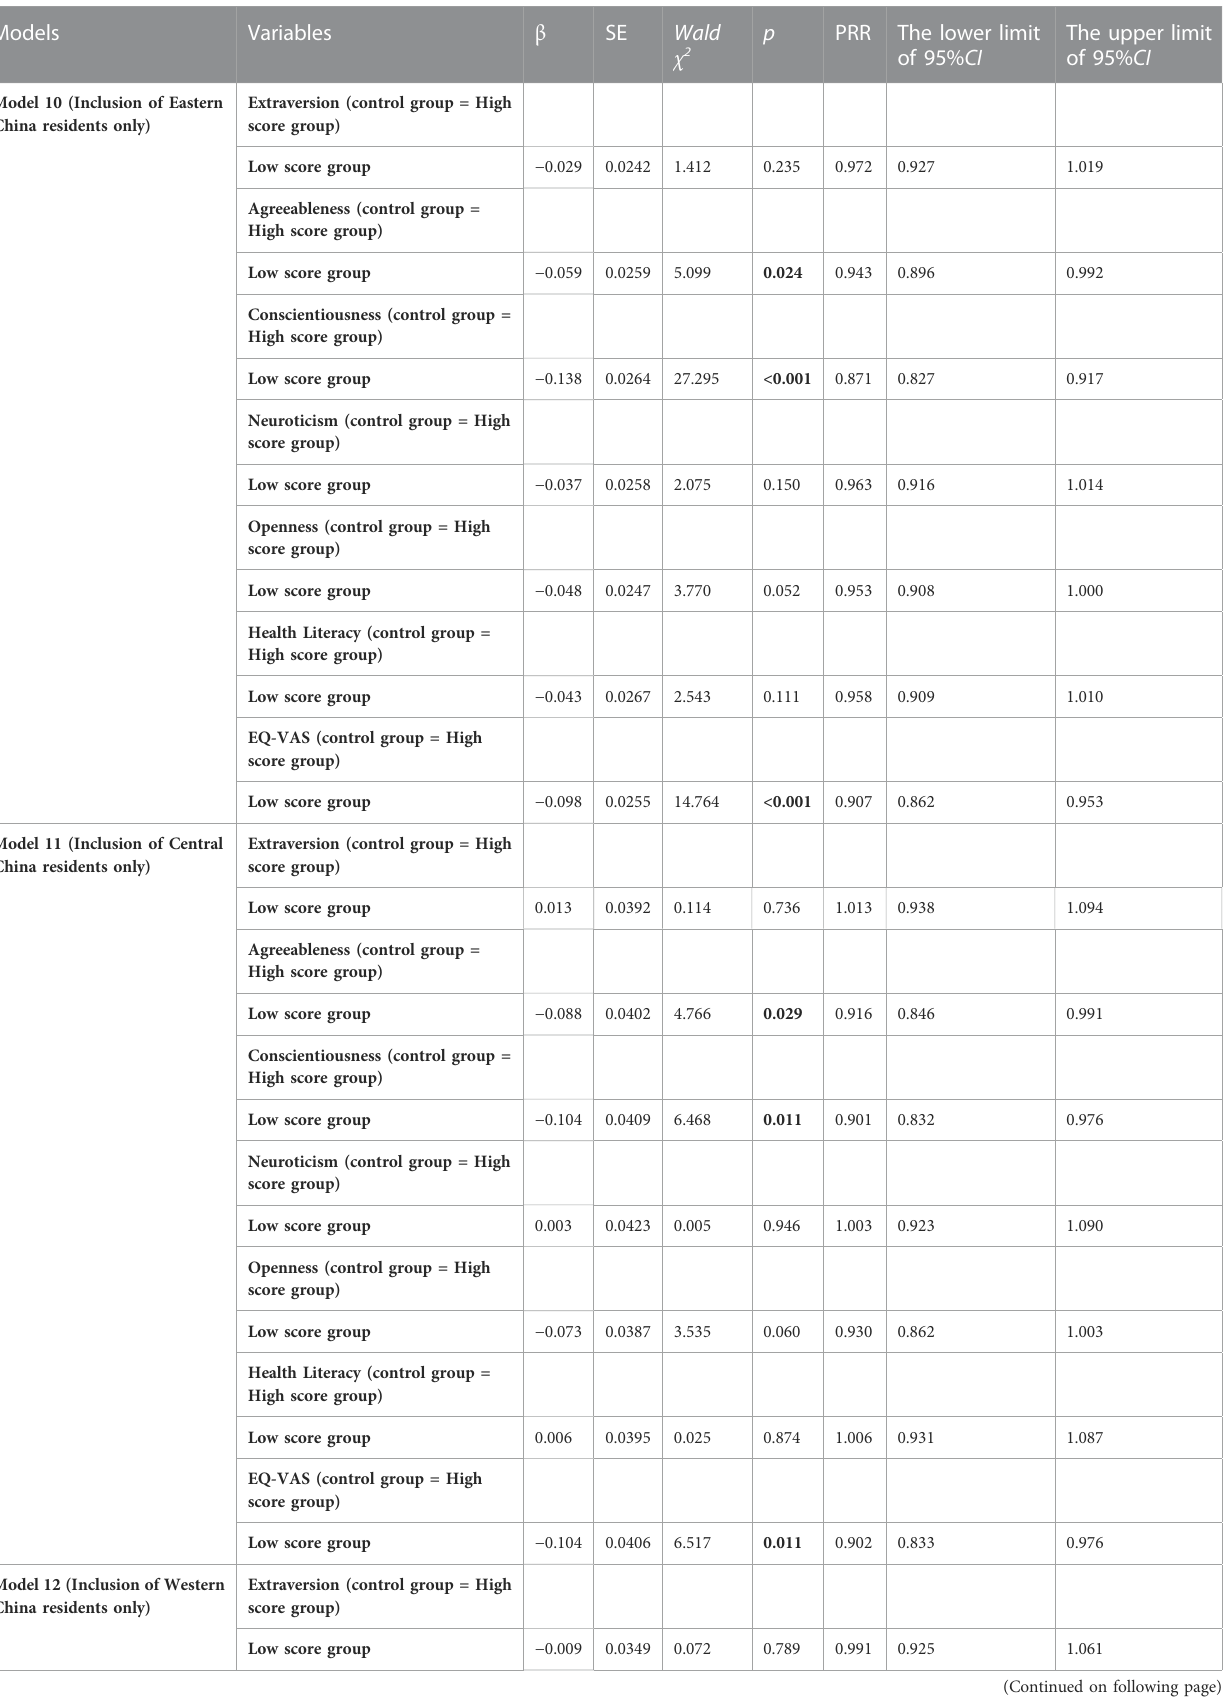
Model 10 (Inclusion of Eastern China residents